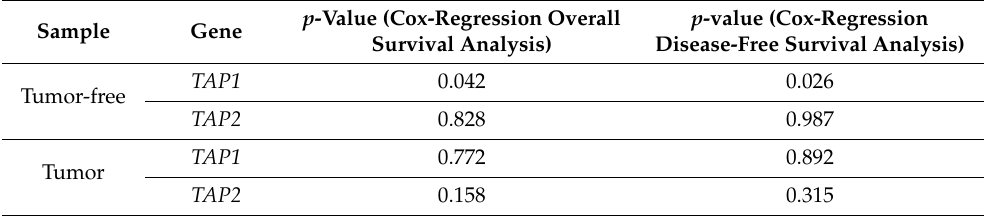
Table 1. Univariate Cox regression analysis of TAP1 and TAP2 .